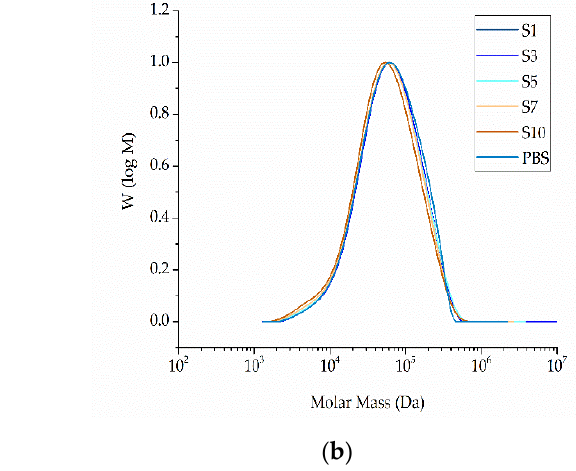
Figure 9. Molar mass distribution curves of PBS and its compounds. ( a ) PBS and compounds containing an increasing weight percentage of curcumin compounded at 200 °C. ( b ) PBS and compounds containing an increasing weight percentage of silver compounded at 200 °C.